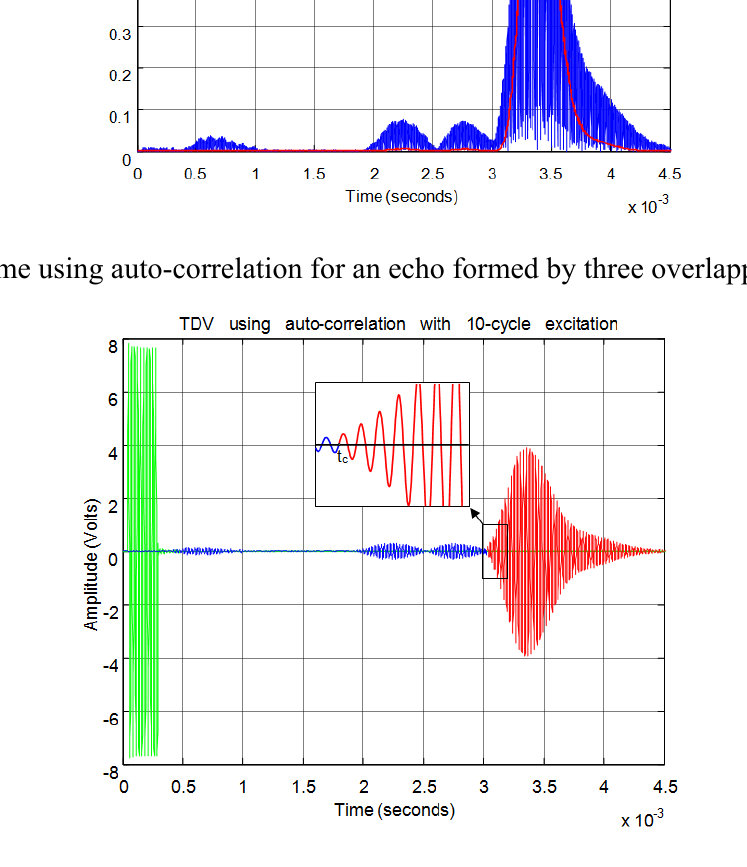
Figure 30. Start time using maximum for an echo formed by three overlapping